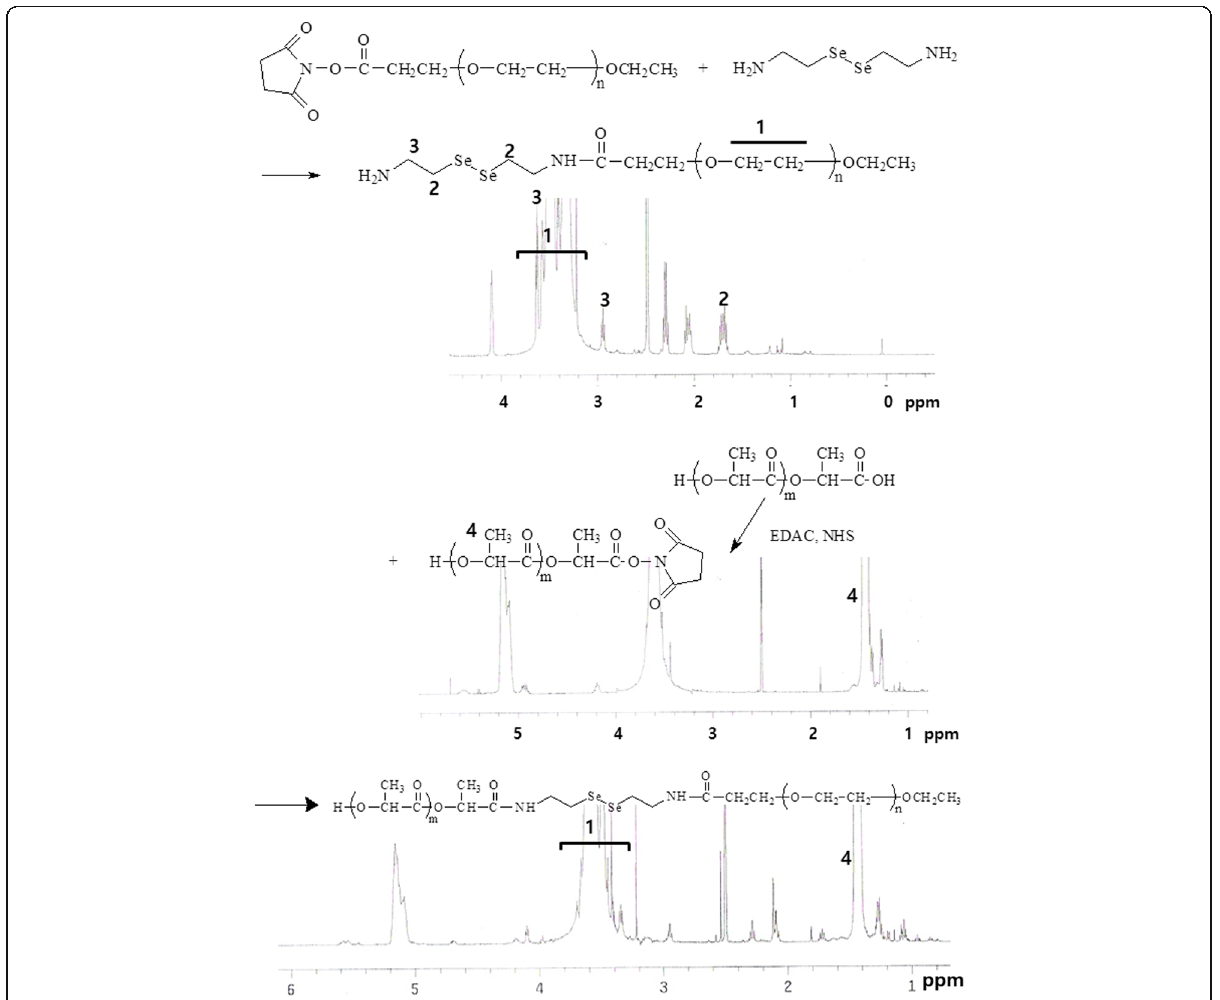
Fig. 1 Synthesis scheme of LEse block